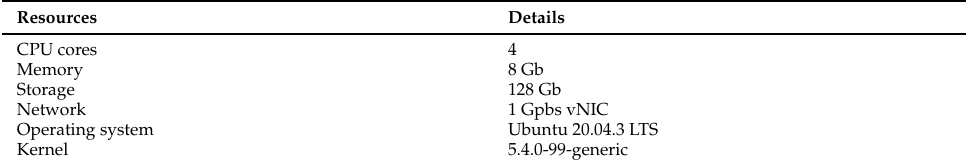
Table 2. Testing node machine